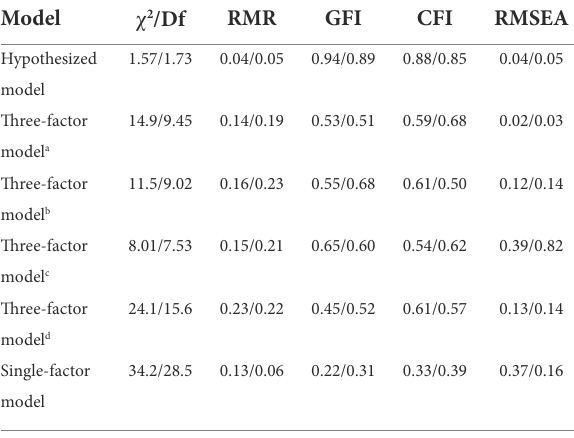
TABLE 3 Results of the model comparison (Pakistan and